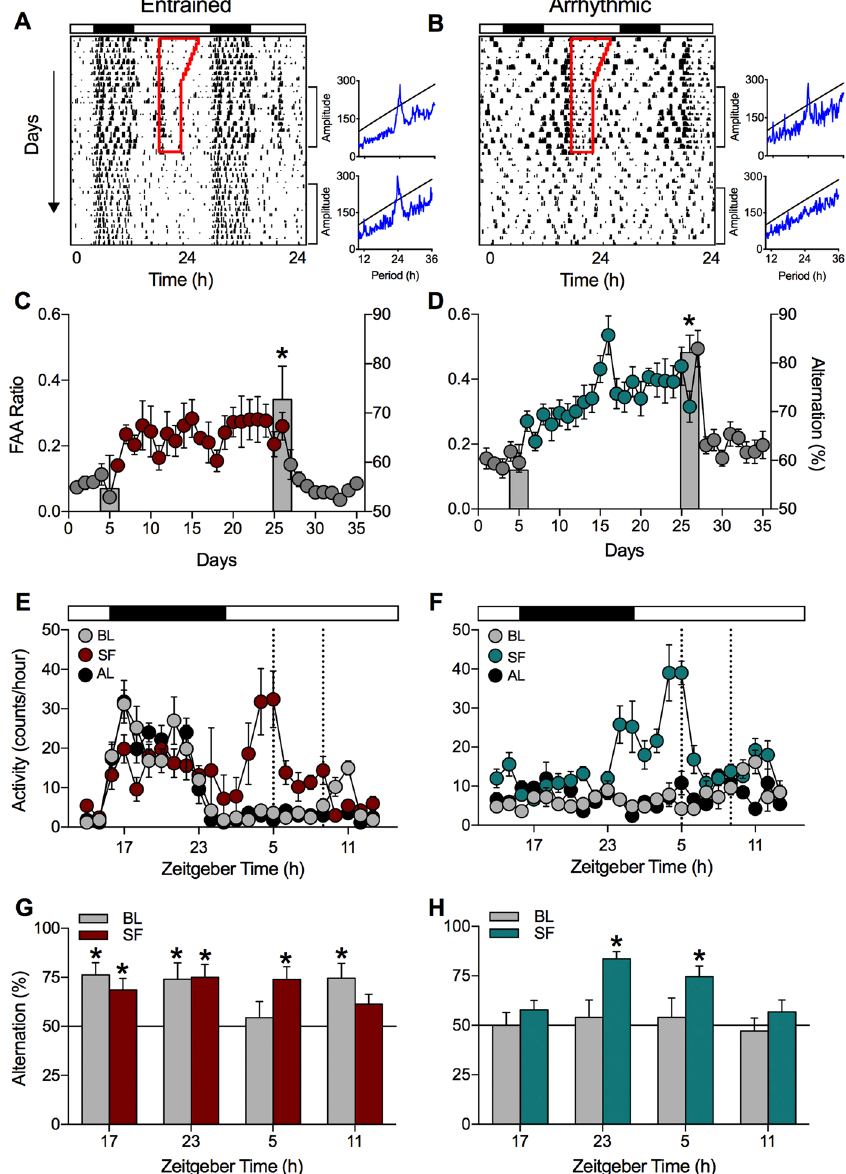
Figure 2. Scheduled feeding rescued spatial working memory in circadian arrhythmic hamsters and phase- delayed the rhythm of test performance in entrained animals. ( A , B ) Time of food availability (red outline) increased food anticipatory activity (FAA) prior to the time of feeding in both entrained (n = 9) and arrhythmic animals (n = 12). Activity returned to baseline levels when animals resumed ad libitum feeding. Brackets indicate portions of the actograms subjected to periodogram analysis. Peaks in blue above the black lines indicate statistically significant rhythms as determined by chi-square periodogram analysis. ( C , D ) The mean ( ± SE) daily FAA ratio was calculated during SF (red, green circles) and ad libitum feeding (gray circles). Gray bars represent the alternation scores (right y-axis) during baseline and on day 21 of SF. * Indicates significantly different from chance (i.e., 50%); P < 0.01. ( E , F ) Waveforms for total (mean ± SE) hourly locomotor activity during each phase of the study (BL = baseline, SF = scheduled feeding, AL = ad libitum) were constructed with the last 5 days of each condition (i.e., the last 5 days in panels C,D during baseline, SF, and AL). Data for each hour were averaged and plotted at the end of that hour (e.g., ZT17 is the mean of data from ZT16-17). Black and white rectangles indicate the times of night and day, respectively. Time of SF indicated by vertical black dotted lines. ( G , H ) Alternation scores during baseline and SF conditions at four different zeitgeber times (ZT; * P < 0.01). ZT17 and ZT23 represent early and late night, respectively. Night and day are indicated by black and white rectangles in panels E,F. Sample sizes (n) for panels G,H: entrained (SF = 9; AL = 10), arrhythmic (SF = 12; AL = 9). All animals remained in a 16:8 light-dark cycle throughout the